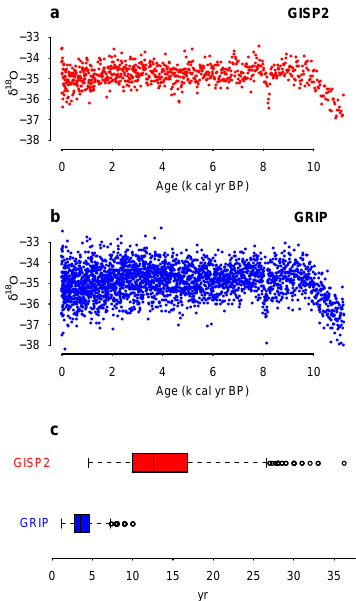
Figure 1. Scatter plots of δ 18 O measurements and ages of (a) GISP2 and (b) GRIP. (c) Boxplots of the time increments clearly show different irregularities in the ages. Note that we have omitted an age difference value of 80.6yr between roughly 1.32 and 1.4kcalyrBP in the boxplot for GISP in order to focus on other significant features. The interquartile ranges (calculation including the omitted value) are (10.0, 12.5, 16.8) and (2.8, 3.5, 4.6)yr for GISP2 and GRIP respectively.